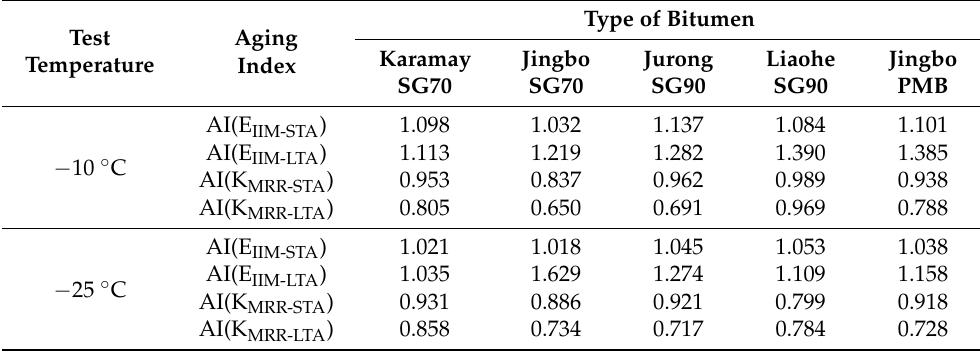
Table 9. The aging indexes based on the initial instantaneous modulus E 0 and modulus relaxation rate K, using the unaged bitumen binder as the